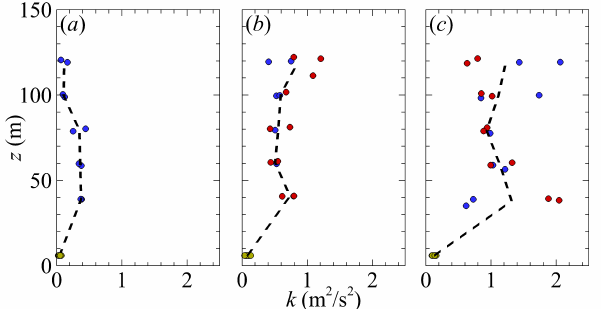
Figure 13. Vertical profiles of turbulent kinetic energy measured during ( a ) flight 1, ( b ) flight 2, and ( c ) flight 3. The blue symbols indicate measurements made by BC5A, the red symbols indicate measurements made by BC5B, and the olive symbols indicate measurements by the sonic anemometer. The dashed line indicates the trend produced by averaging measurements at each